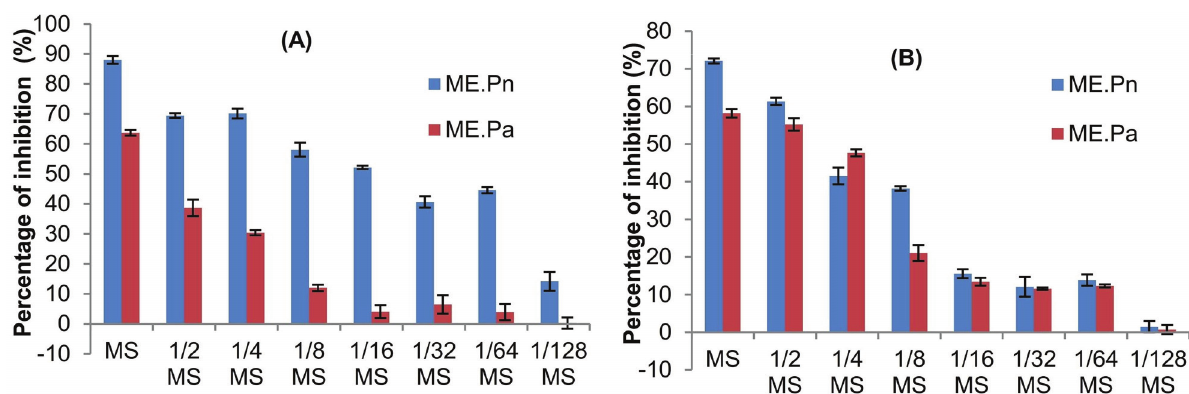
FIGURE 3 - The effect of P. Nigra methanolic extract (ME. Pn) and P. Alba methanolic extract (ME. Pa) on the attachment of methicillin resistant S. aureus (MRSA) ATCC 43300 (A) and of S. aureus ATCC 6538 (B), expressed as percentage inhibition.